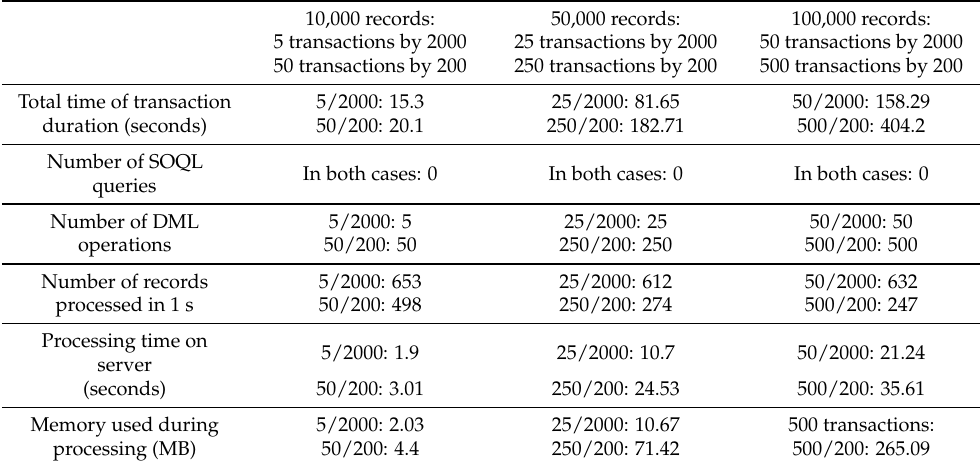
Table 1. Batch Apex processing results for insert